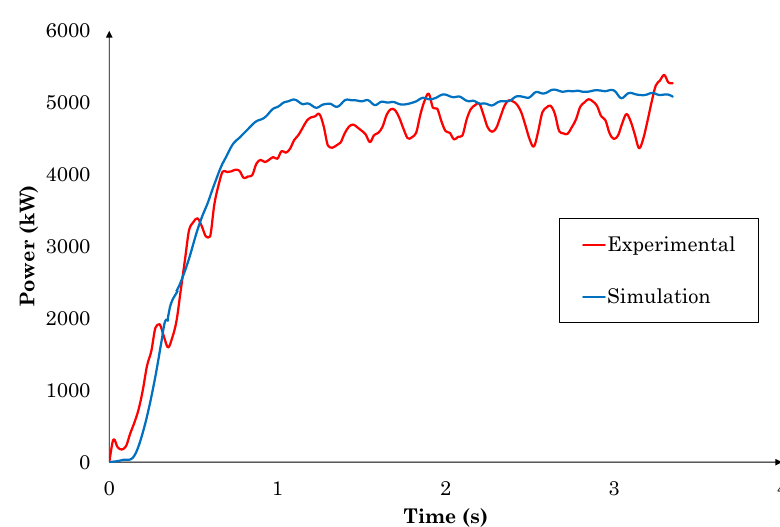
Figure 10. Comparison of power consumption of the rotary piercing machine.